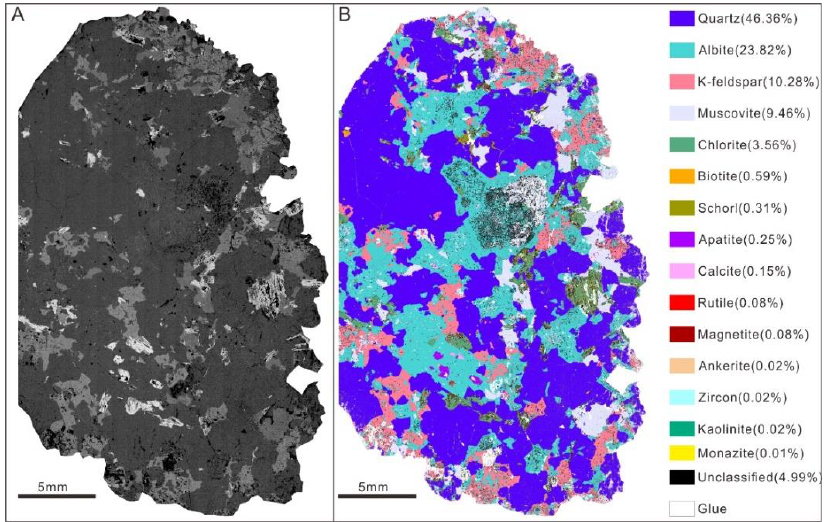
Figure 4. ( A ) BSE photo of Baishi granite. ( B ) Phase map and composition of Baishi